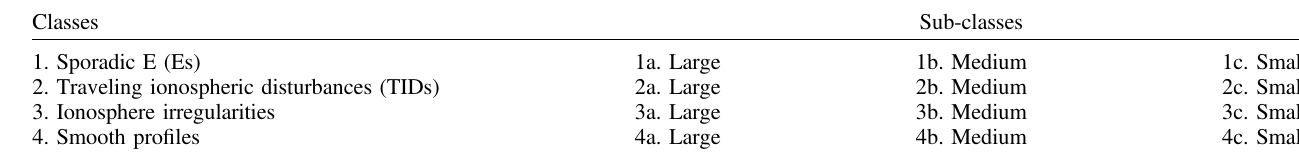
Table 1. Ionospheric perturbations